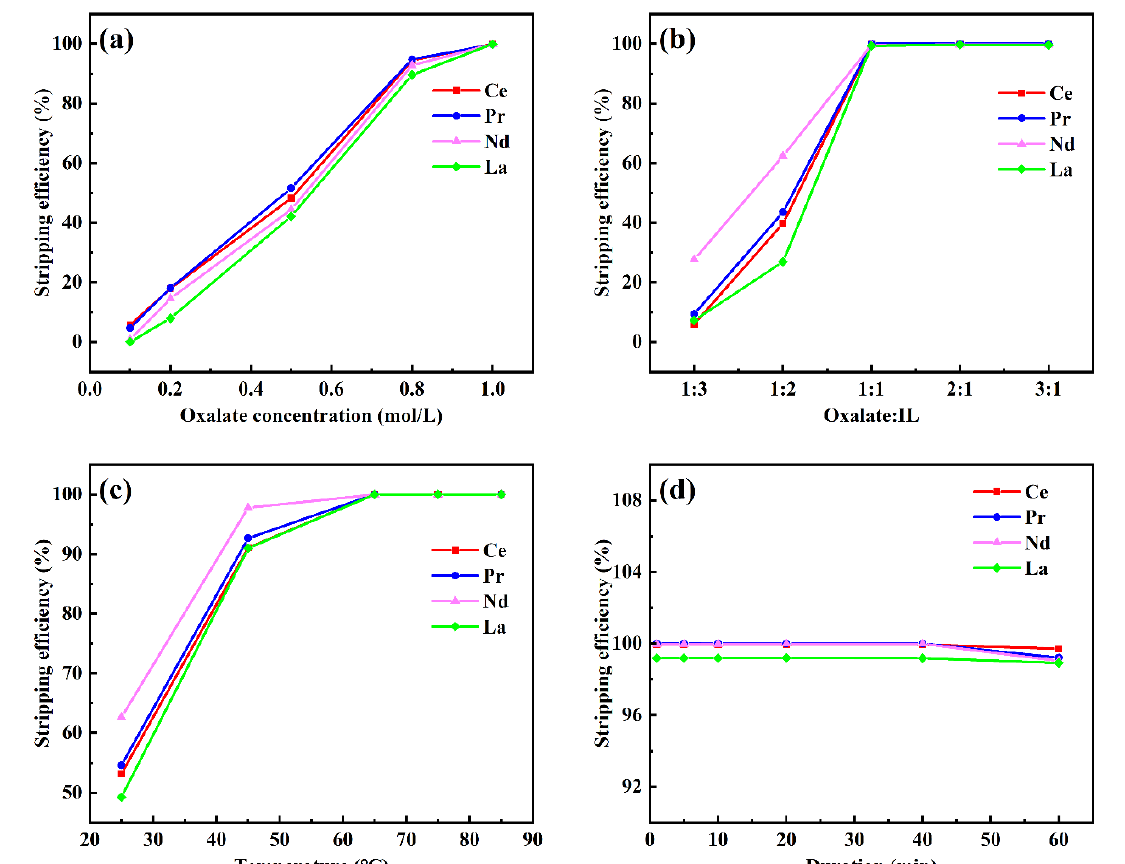
Figure 10. Back extraction of REEs from [Hbet][Tf 2 N] using the oxalic acid solution. The influence of oxalic acid concentration ( a ), the volume ratio of oxalic acid solution and IL ( b ), temperature ( c ), and reaction duration ( d ) on the back extraction efficiency.